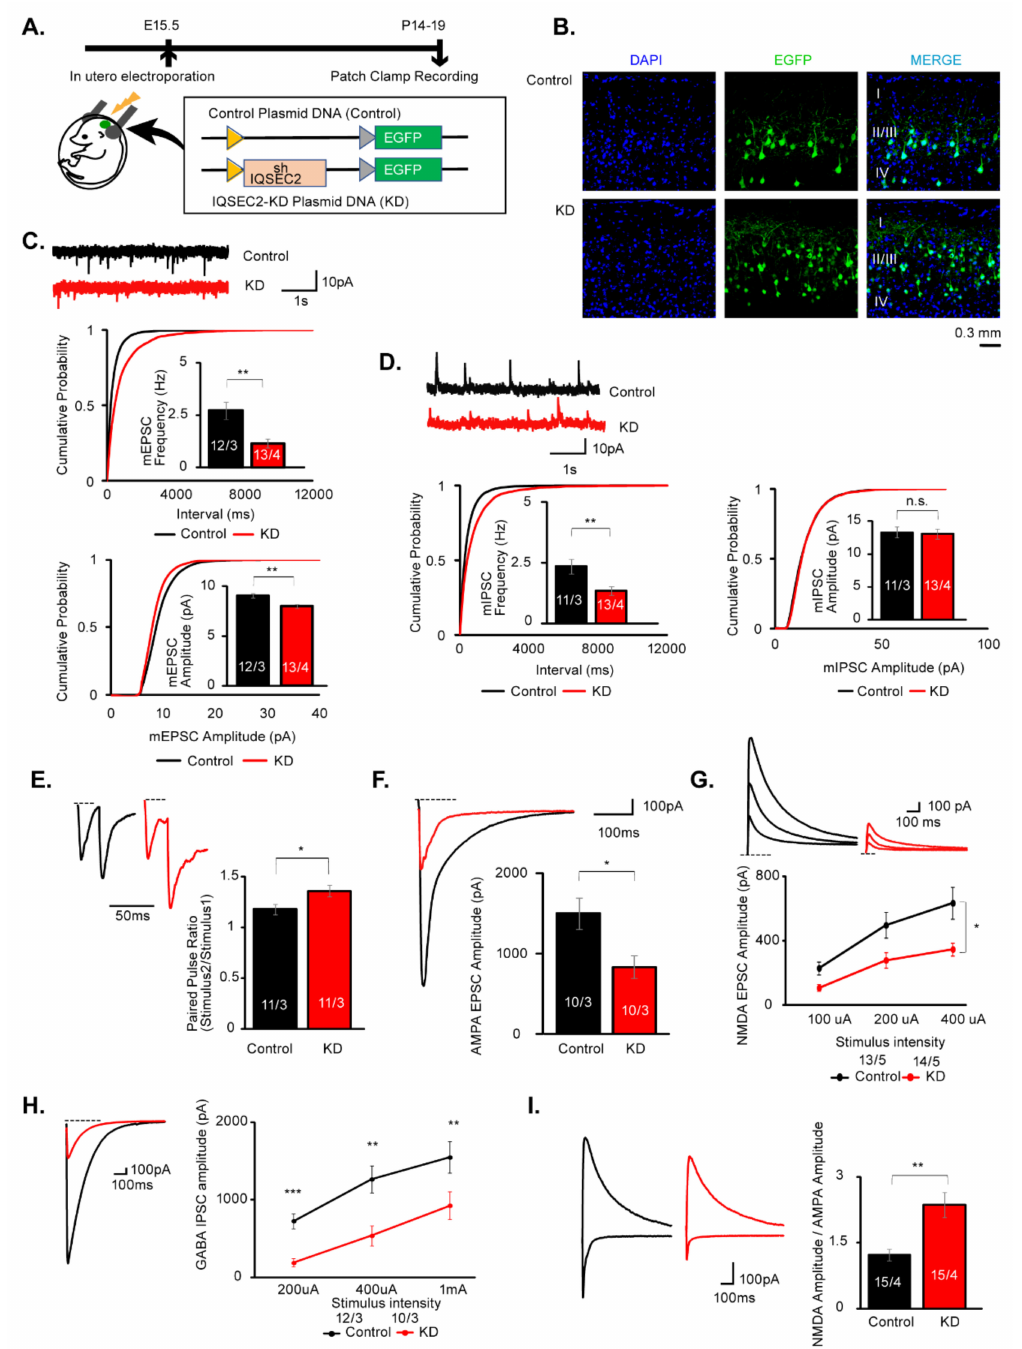
Figure 4. AMPAR, NMDAR, and GABAR-mediated synaptic transmissions are decreased in IQSEC2 KD pyramidal neurons in layer 2/3 of the somatosensory cortex. ( A ) Schematic diagrams for the experimental design and plasmid DNAs for Control and IQSEC2-KD used for the IQSEC2 KD experiment. ( B ) Confocal microscopic images for control and IQSEC2-KD